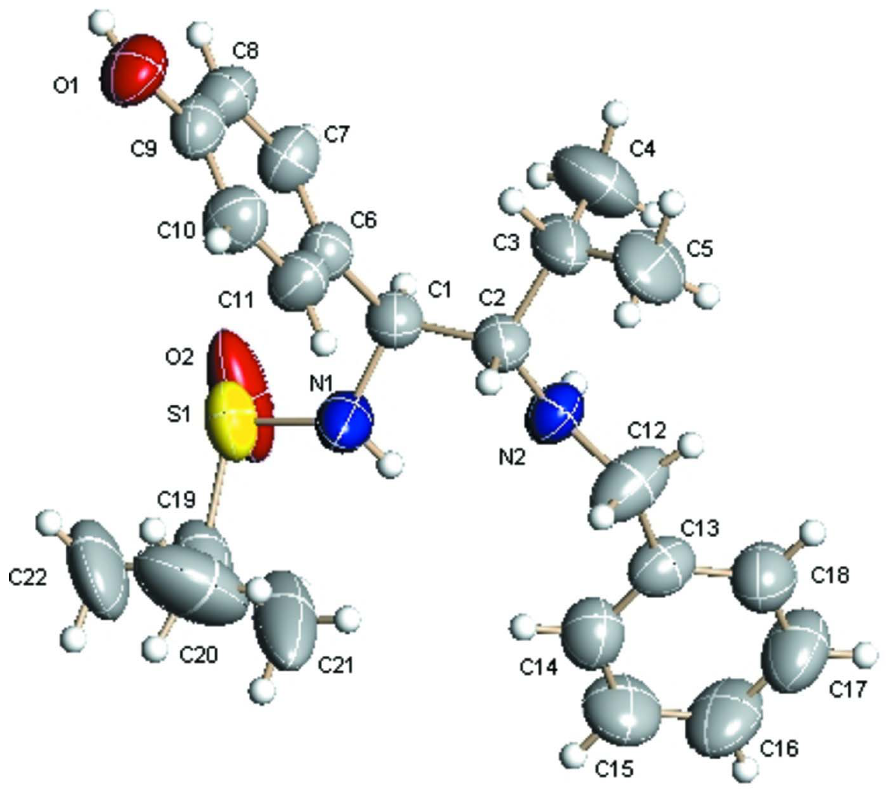
Figure 1 H N O S at the 50% probability level. H atoms are drawn as spheres of arbitrary Plot of C 22 32 2 2